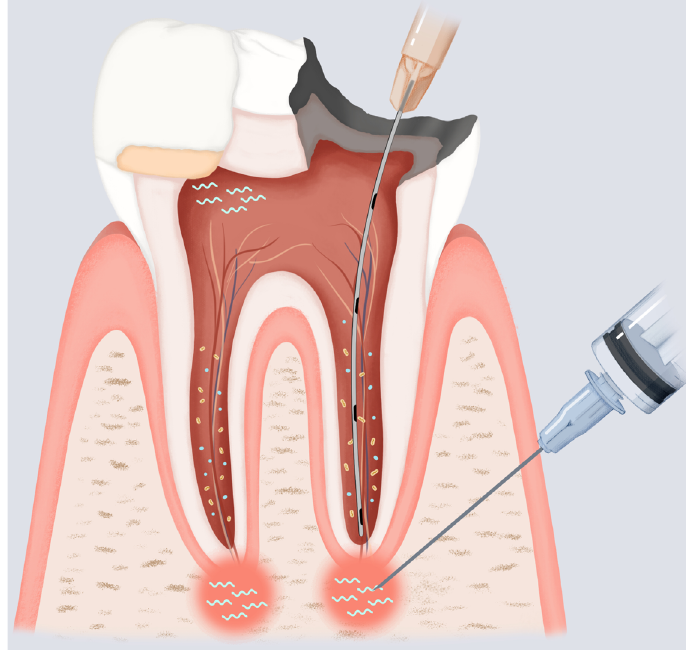
Figure 1- Potential clinical translation for the use of miRNAs in the treatment of pulpal and periapical diseases. As many novel miRNAs are being unveiled, they have the potential to be translated into chairside diagnostic biomarkers and therapeutic agents. For example, before any endodontic treatment, pulpal/periapical fluid and blood can be easily sampled using instruments such as syringes or microcannulas, from which miRNA levels can be assessed. Based on the differential expression patterns of specific miRNAs that are associated with characteristics and/or prognostic factors of apical periodontitis, informed decision-making can be achieved, and patient-centered treatment options can be tailored and rendered. On the other hand, if specific miRNAs are known to play a role in pro- and anti-inflammatory process, their inhibitors/mimics can be applied to inflamed pulp tissues in conjunction with conventional vital pulp therapies such as direct pulp capping or delivered to the root canals and periapical regions using microcannulas during root canal therapies to promote better healing